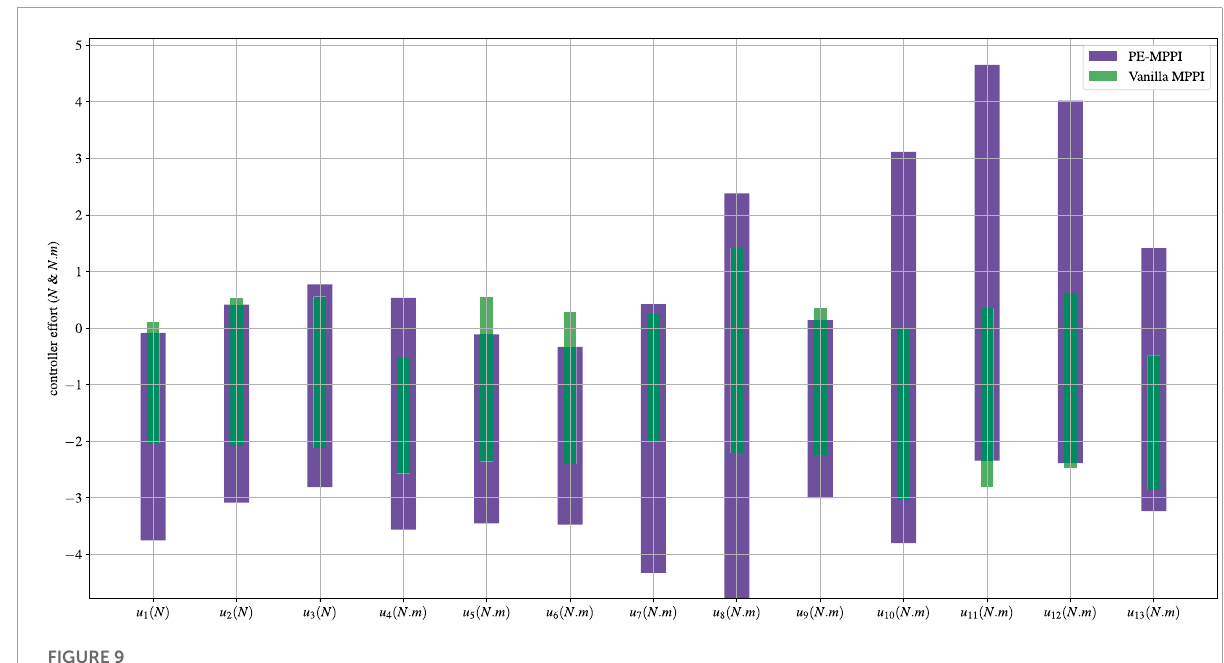
FIGURE 9 The space robot control effort bounds in the system identification and actuator failure